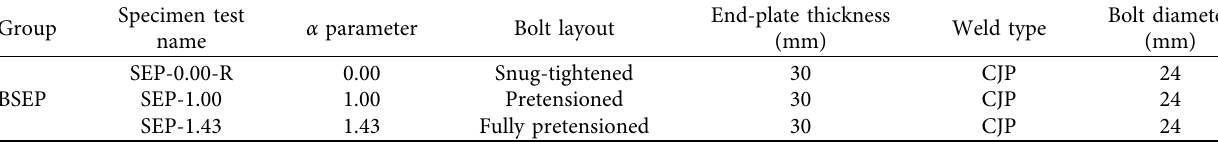
Table 1: Details of the test specimens.